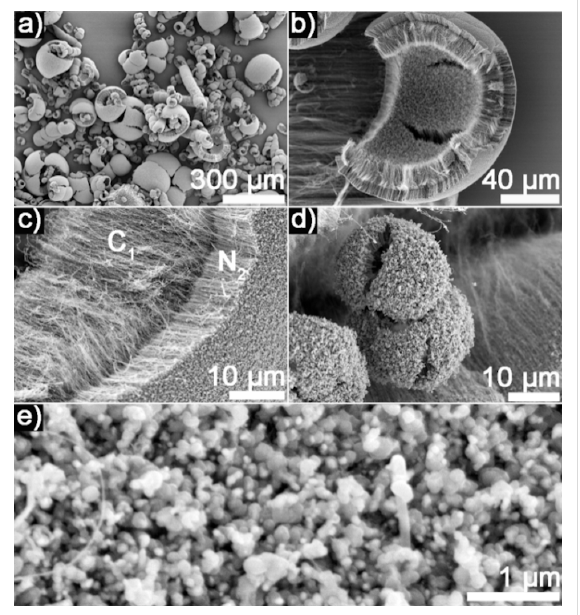
Figure 3: (a–e) SEM micrographs of the powder collected after the synthesis of C 1 /N 2 /C 3 structures. (e) The outer surface of the rolled structure, brighter in the SEM micrograph, is made of iron catalyst par-